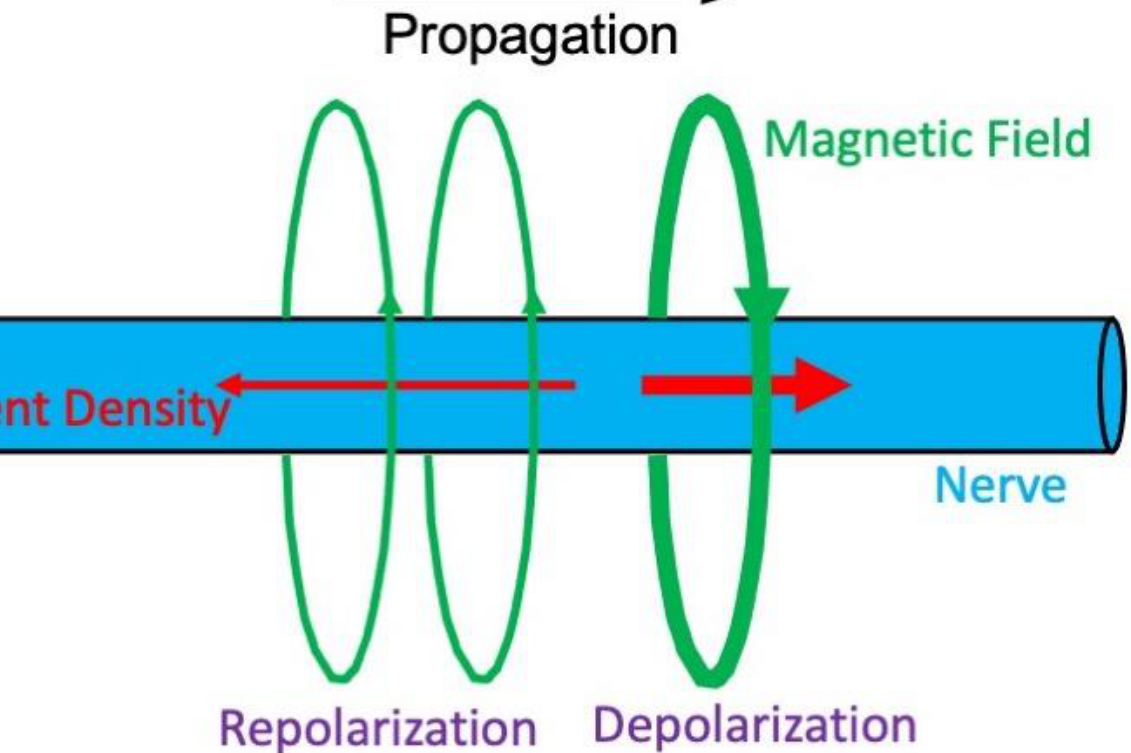
Figure 2. The magnetic field produced by an action potential in a peripheral nerve [9,10]. The action potential propagates from left to right down the cylindrical nerve (blue). Current (red) associated with the depolarization phase of the action potential points in the direction of propagation and current associated with the repolarization phase points opposite to the direction of propagation. The magnetic field (green) wraps around the action current.